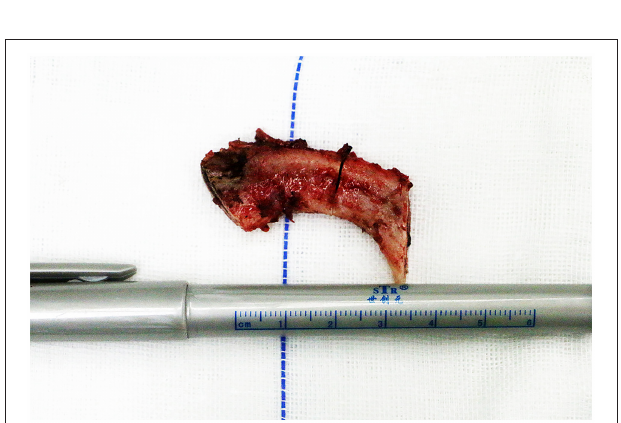
FIGURE 1 | Image of the partial exposure of the first rib. The brachial plexus is retracted medially, and the middle scalene muscle is partially excised and detached to expose the first rib.